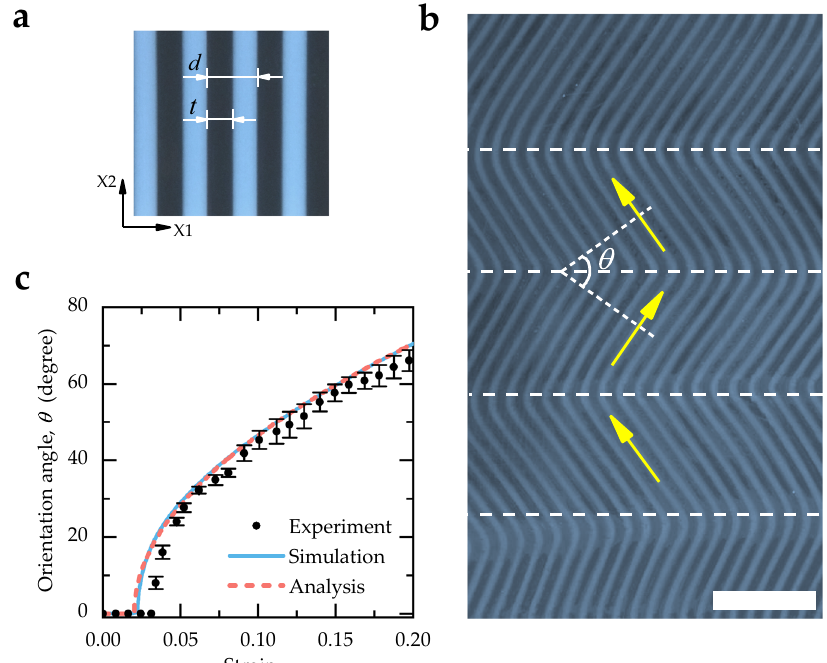
Fig. 1 Twinning pattern in soft laminate. a Schematic illustration of periodic layered composites. b Instability-induced twinning microstructure in layered composite with c ð l Þ ¼ 0 : 50 at strain level ε = 0.16. Scale bar: 10 mm. c Evolution of domain orientation angle as a function of applied strain. Error bars refer to standard deviations of the experimentally calculated orientation angles based on selected